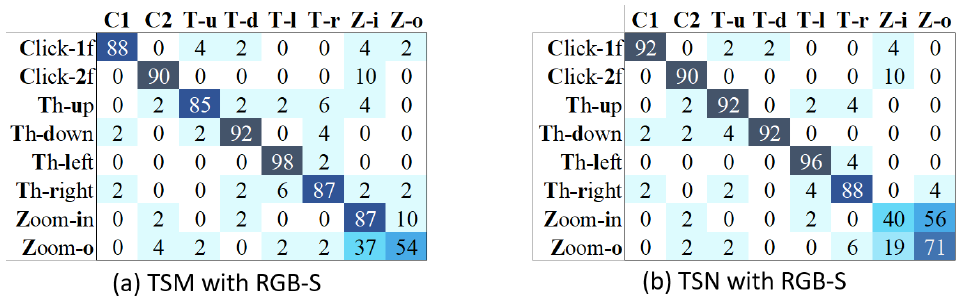
Figure 12. Confusion matrices of TSM and TSN are estimated by excluding the repetitive classes of open twice and